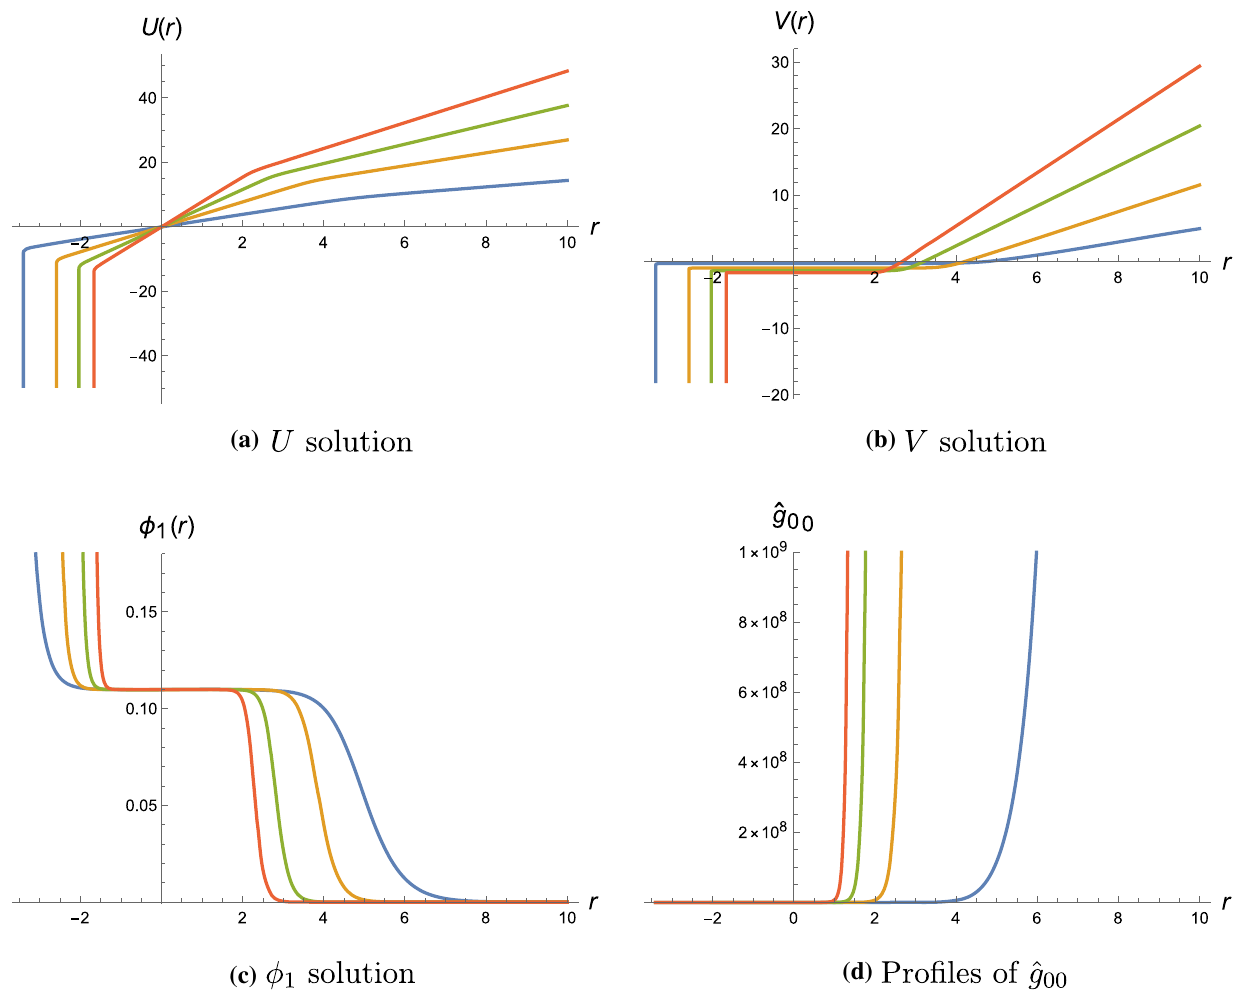
Fig. 21 RG flows from the N = 4 AdS 7 critical point to the AdS 3 × CH 2 fixed point and curved domain walls with φ 1 → ∞ and φ 2 = φ 3 = 0 for SO ( 3 ) ∼ SU ( 2 ) twist in SO ( 5 ) gauge group. The blue, orange, green and red curves refer to g = 8 , 16 , 24 , 32,